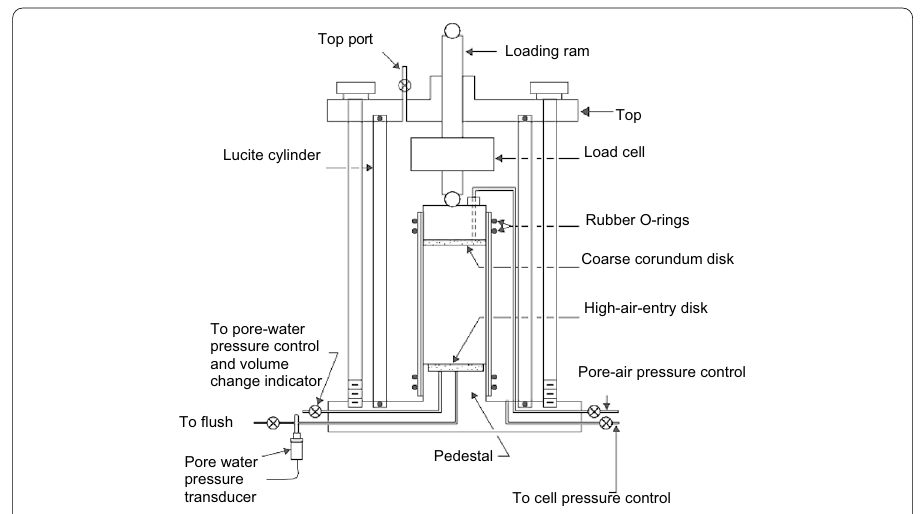
Fig. 9 Schematic of a modified triaxial apparatus for testing unsaturated soils [6]